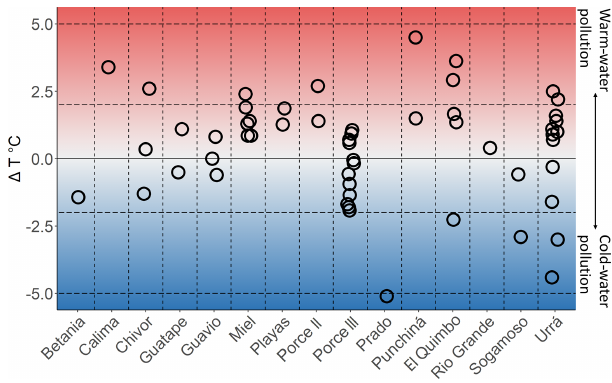
Figure 4. Differences in dissolved oxygen between the upstream inflowing river surface and the river surface downstream of 15 hy- dropower dams in Colombia. Each point represents one pair of con- temporaneous measurements from the most recent year of available data (either 2018 or